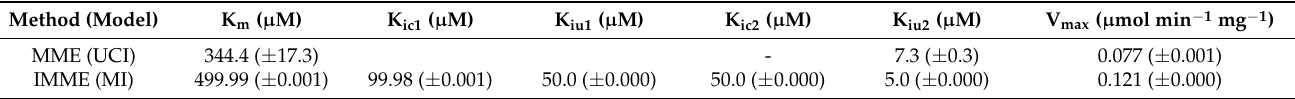
Table 5. Summary of obtained constants with discriminated best fit